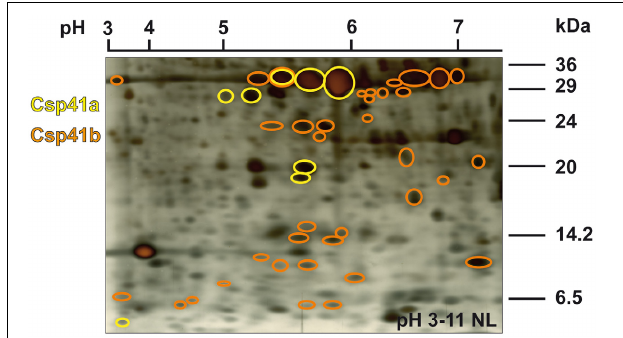
FIGURE 5 | Distribution of CSP41a and b spots in the pH 3–11 NL 2D-gel. CSP41a is drawn in yellow and CSP41b in orange. Marker sizes and pH range are given right beside and above the silver stained gel,